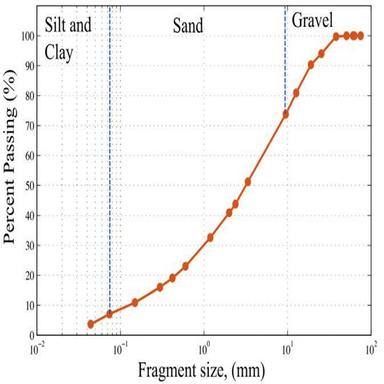
Unconfined compression for three samples at Diablo Regimiento mine .